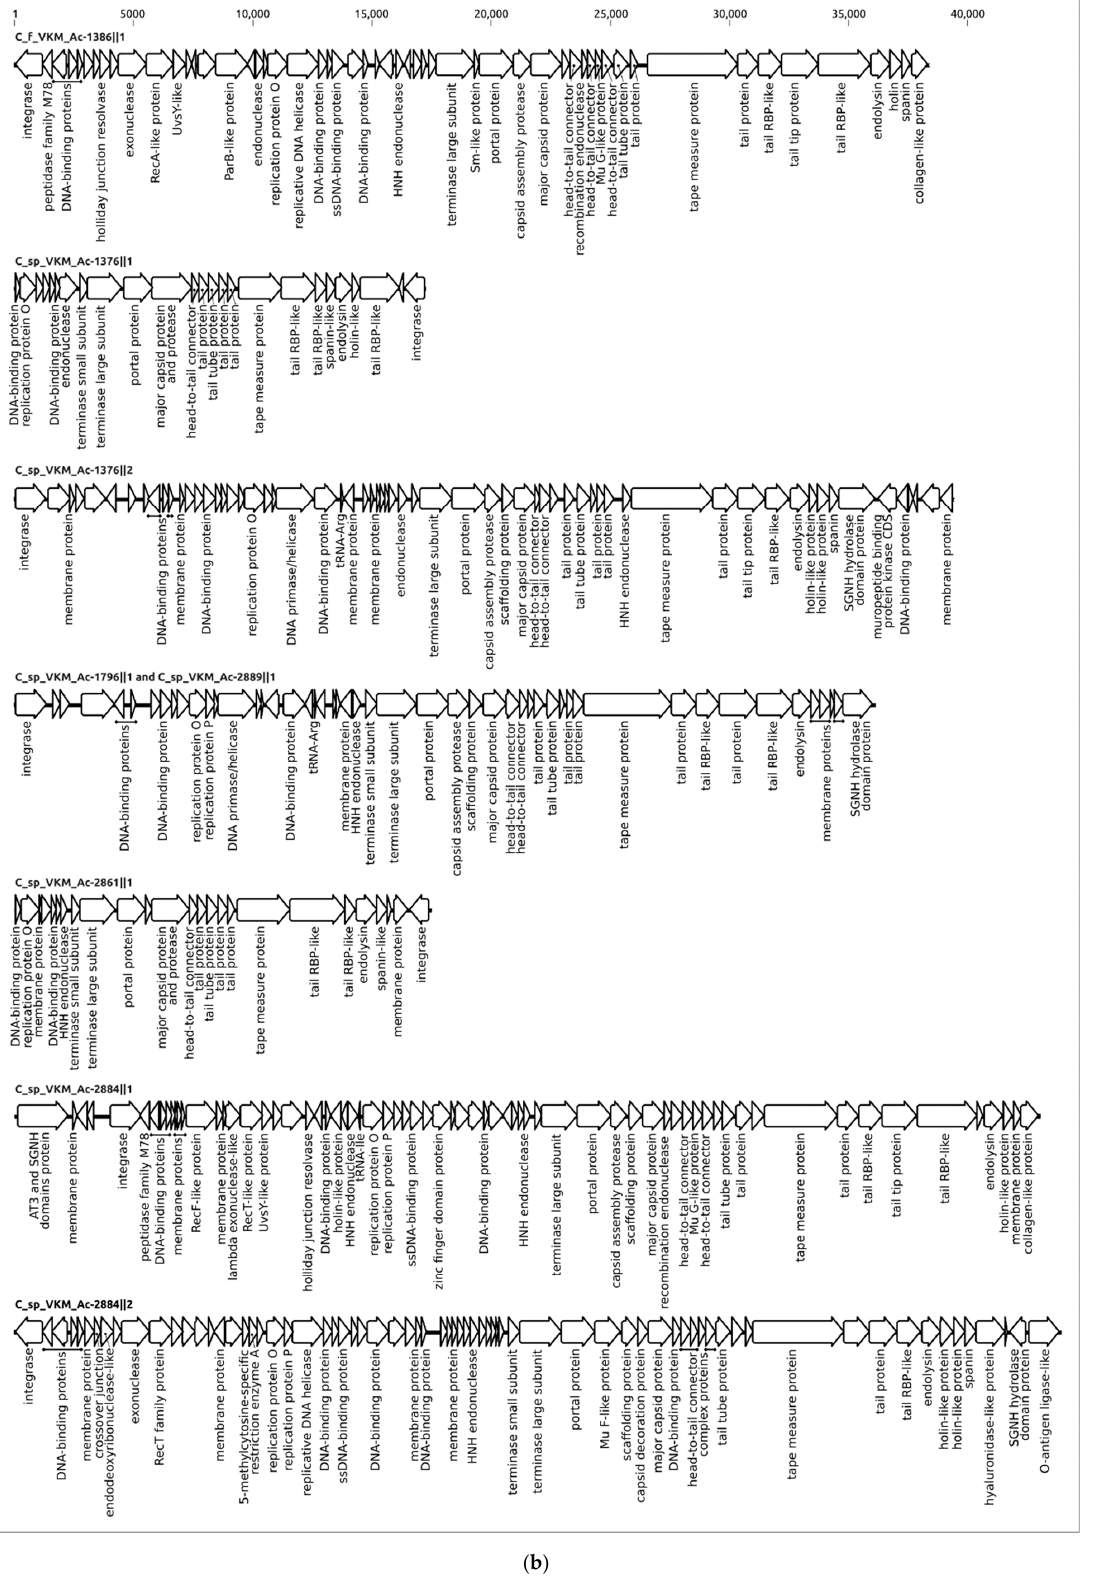
Figure 5. ( a ) Simplified genetic maps of the representatives of each putative prophage cluster shown in Figure 4. ( b ) Genetic maps of seven putative prophages predicted to be contained in Curtobacterium genomes of VKM collection strains. Arrows indicate the direction of